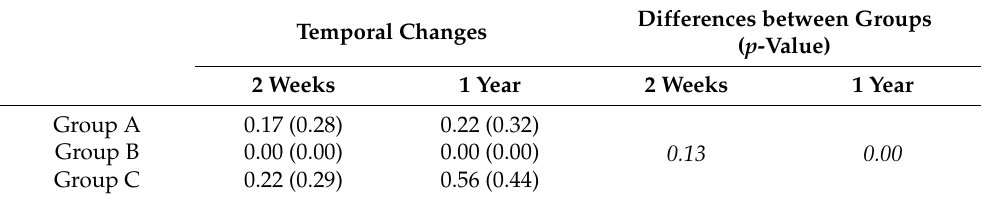
Table 5. Analysis of the plaque retention index: temporal changes and differences between the groups. Temporal Changes